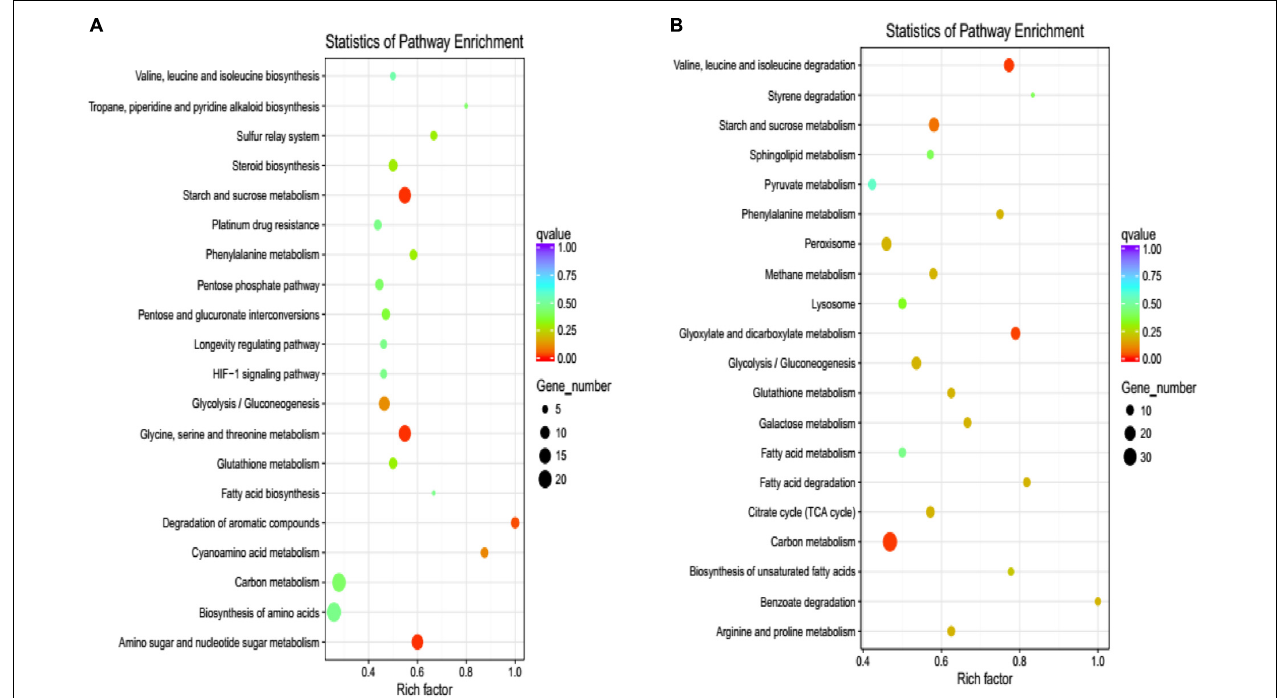
FIGURE 7 | KEGG pathway enrichment of DEGs. (A) The graph shows enriched KEGG terms for downregulated DEGs influenced by the gene deletion. (B) The pathways of enriched KEGG terms for upregulated DEGs influenced by the gene deletion. Rich factor is the ratio of the differentially expressed gene number to the total gene number in a certain